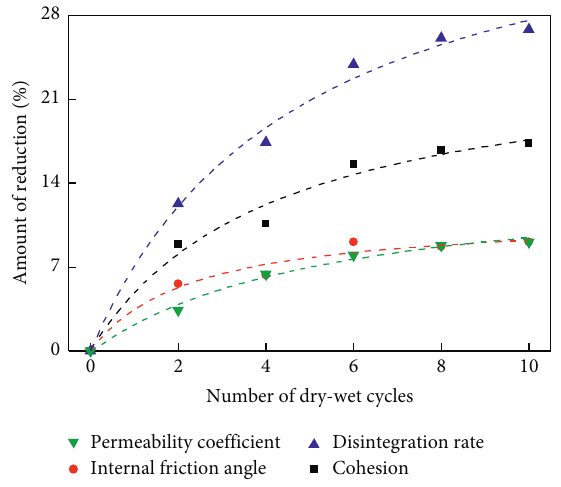
Figure 5: The effects of D-W cycles on the reduction of the antierosion ability parameters with the number of cycles. Table 3: Fitting parameters of antierosion ability parameter re- duction of the reinforced loess during D-W cycles.